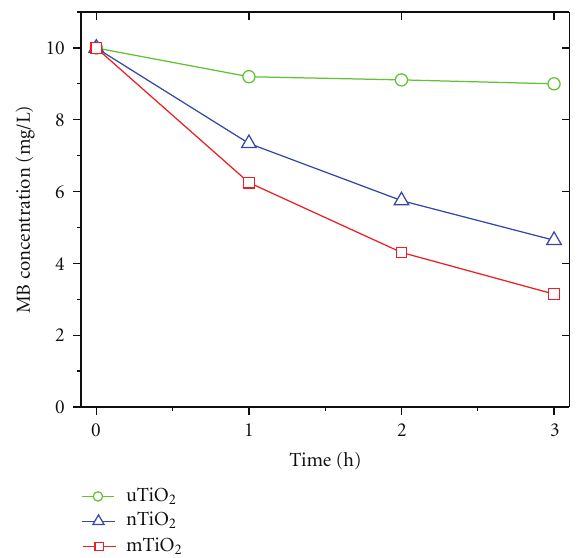
Figure 8: MB degradation of the mTiO 2 , nTiO 2 , and uTiO 2 films under BLED